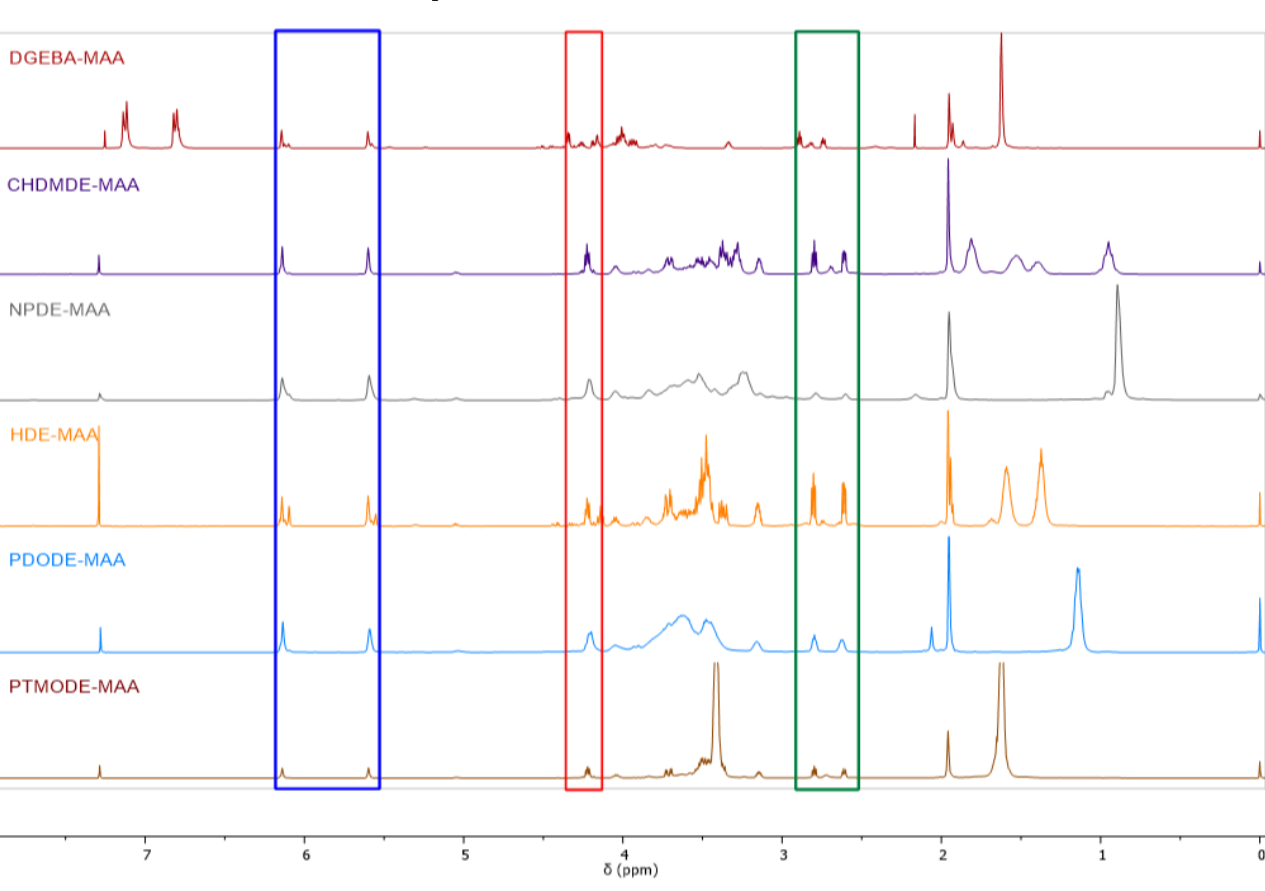
Figure 2. 1 H NMR spectra of epoxy methacrylated pre-polymers. Table 2. Molar ratios of relevant epoxy methacrylate pre-polymers.